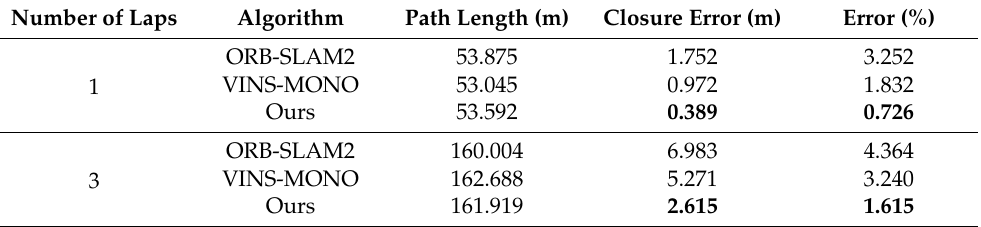
Table 4. Comparison of the closure errors of algorithms. Bold numbers represent the best performances. Number of